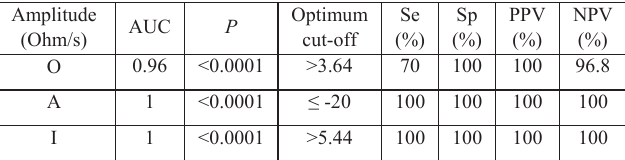
Table 3. ROC curve analysis of O-wave amplitude, A-wave amplitude, and the characteristic parameter “I”